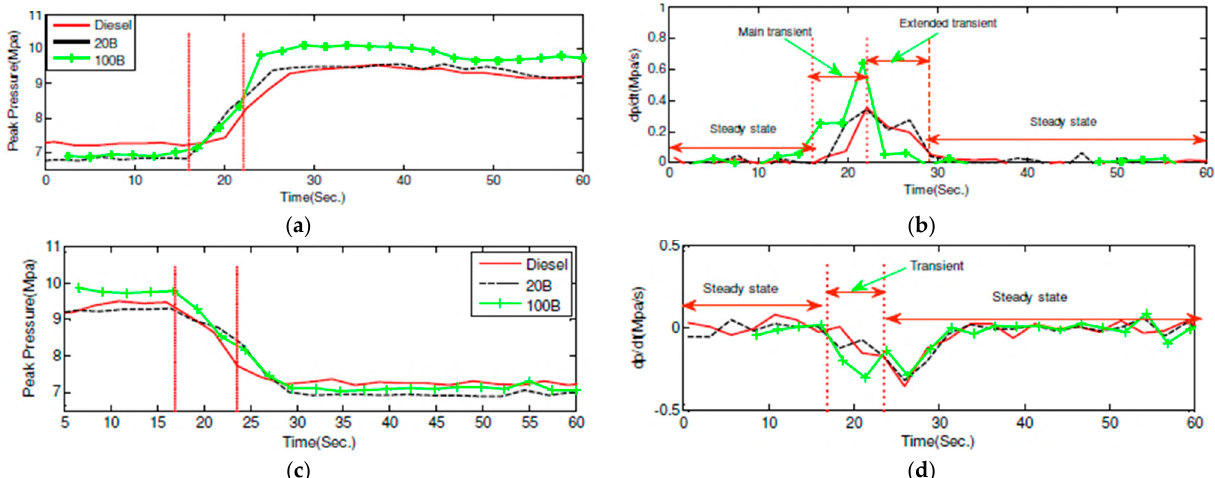
Figure 8. ( a ) In-cylinder peak pressure variation for the CI with different fuels during positive torque transient and the ( b )